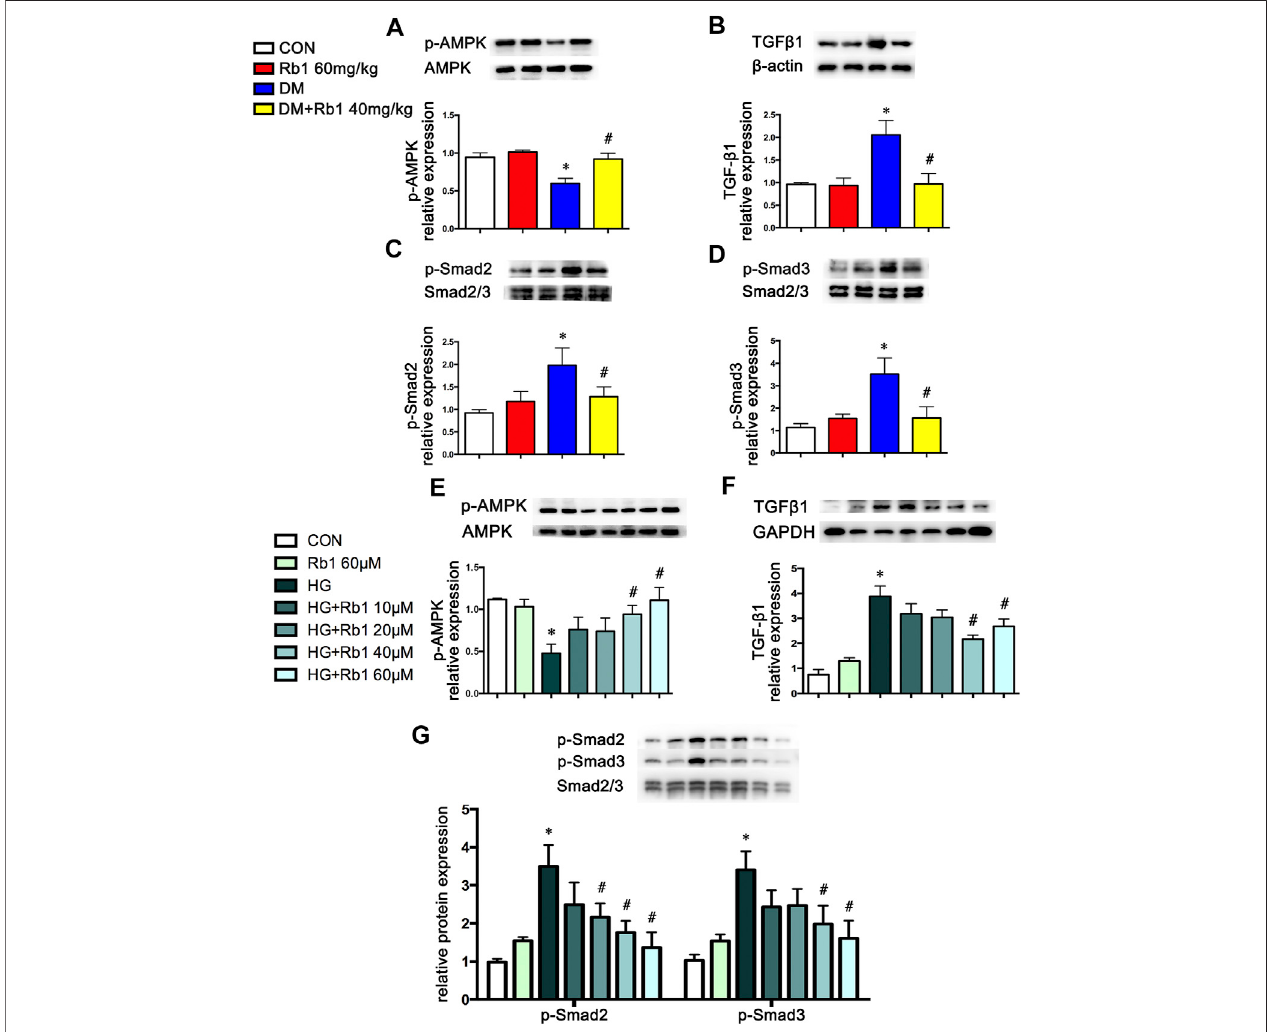
FIGURE 3 | AMPK pathway is involved in the effect of Rb1 on DM- and HG-mediated TGF β 1, Smad2/3, and collagen expression. Representative Western blot bands and semiquantitative analysis of (A) phosphorylated AMPK (p-AMPK), (B) TGF β 1, (C) phosphorylated Smad2 (p-Smad2), and (D) phosphorylated Smad3 (p-Smad3) inaorta extracts. (E – G) VSMCs were treatedwithRb1 at dosesof10, 20,40, and 60 μ M inahigh-glucosemedium.Representative Western blot bandsand semiquantitative analysis of phosphorylated AMPK (p-AMPK), TGF β 1, phosphorylated Smad2 (p-Smad2), and phosphorylated Smad3 (p-Smad3). Semiquantitative analysis of above proteins expressions. Data are mean ± SEM. n (cid:2) 5 – 6, * p < 0.05 vs. Control; # p < 0.05 DM + Rb1 vs. DM and HG + Rb1 vs. HG.